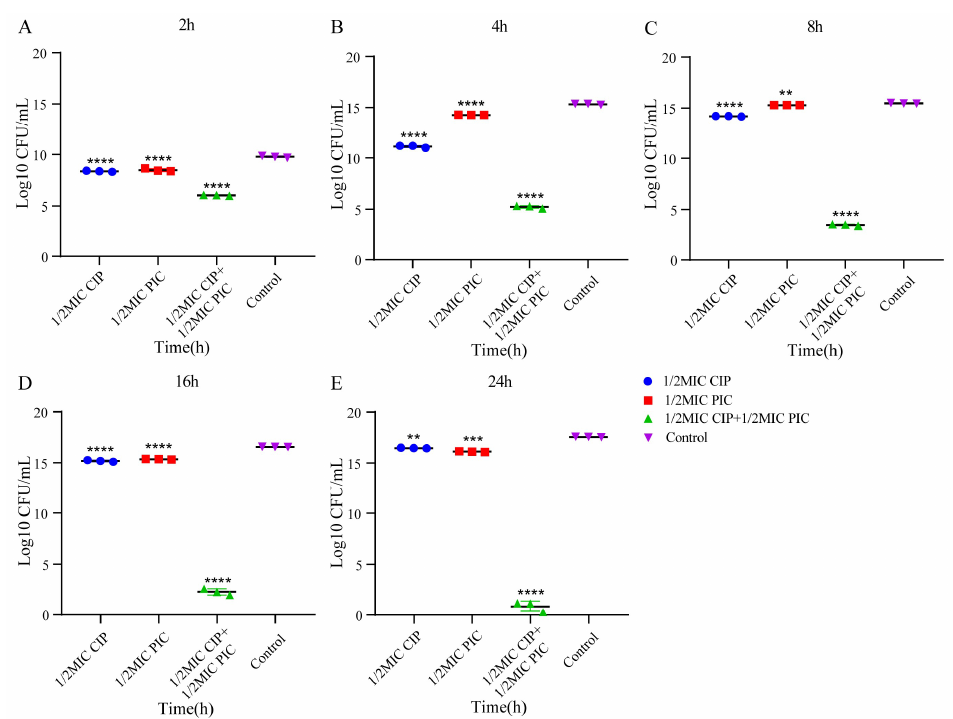
Figure 1. Statistical analysis of bacteria colonies of S. aureus J-14 at different times. ( A ) 2 h, ( B ) 4 h, ( C ) 8 h, ( D ) 16 h, ( E ) 24 h. n = 3. Results from all experiments are presented as the mean ± SD of three replicates. ** = p < 0.01, *** = p < 0.001, **** = p < 0.0001.